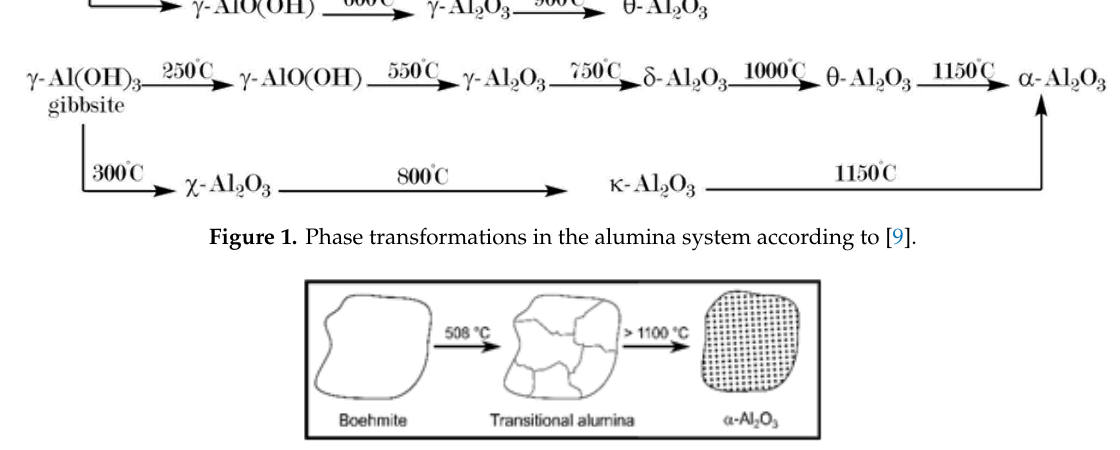
Figure 2. Correlation between boehmite and corundum crystallite sizes adapted from [11].